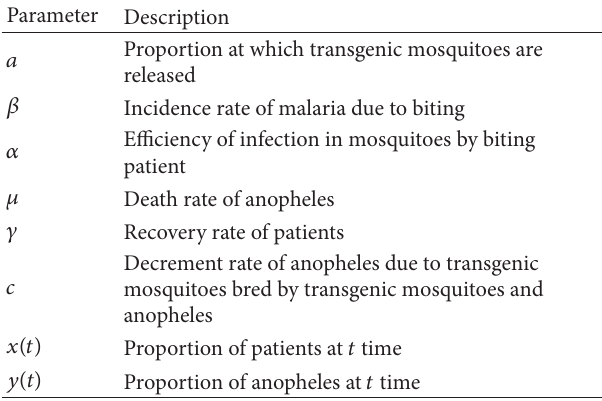
Table 1: Descriptions of the parameters in system